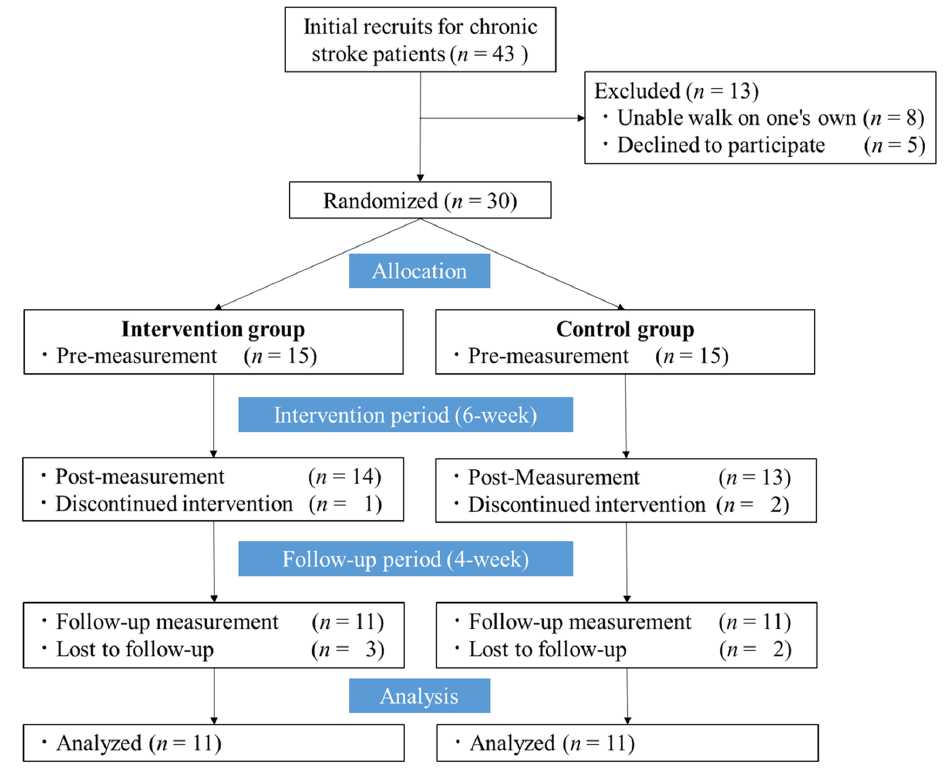
Figure 2. Time course of the study. Table 1. Participants’ characteristics at analysis.